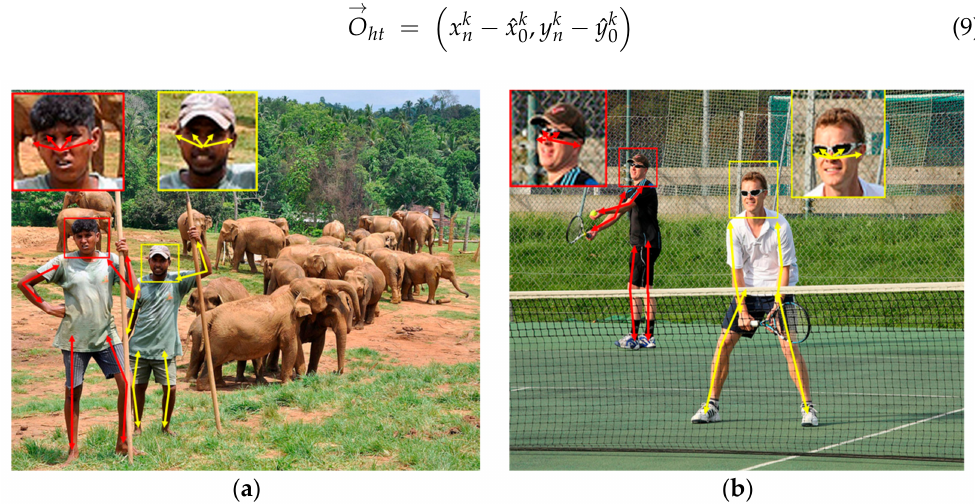
Figure 4. PPR of the head (magnified area) and PPR of the limbs in different people. ( a , b ) are two samples from COCO dataset [31]. The lengths of the offset vectors in the head part are much shorter than those in the limb